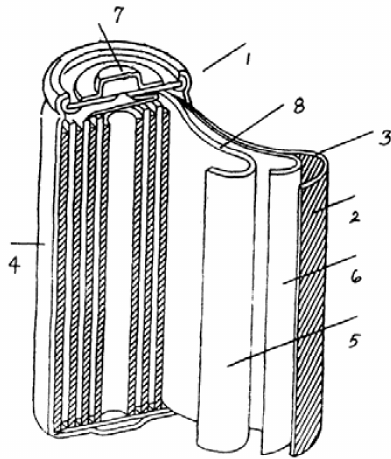
Figure 13. Schematic diagram of a basic structure of a cell with 1: Ni/MH battery, 2: negative electrode, 3: negative substrate, 4: can, 5: positive electrode, 6: separator, 7: vent cap, and 8: positive substrate